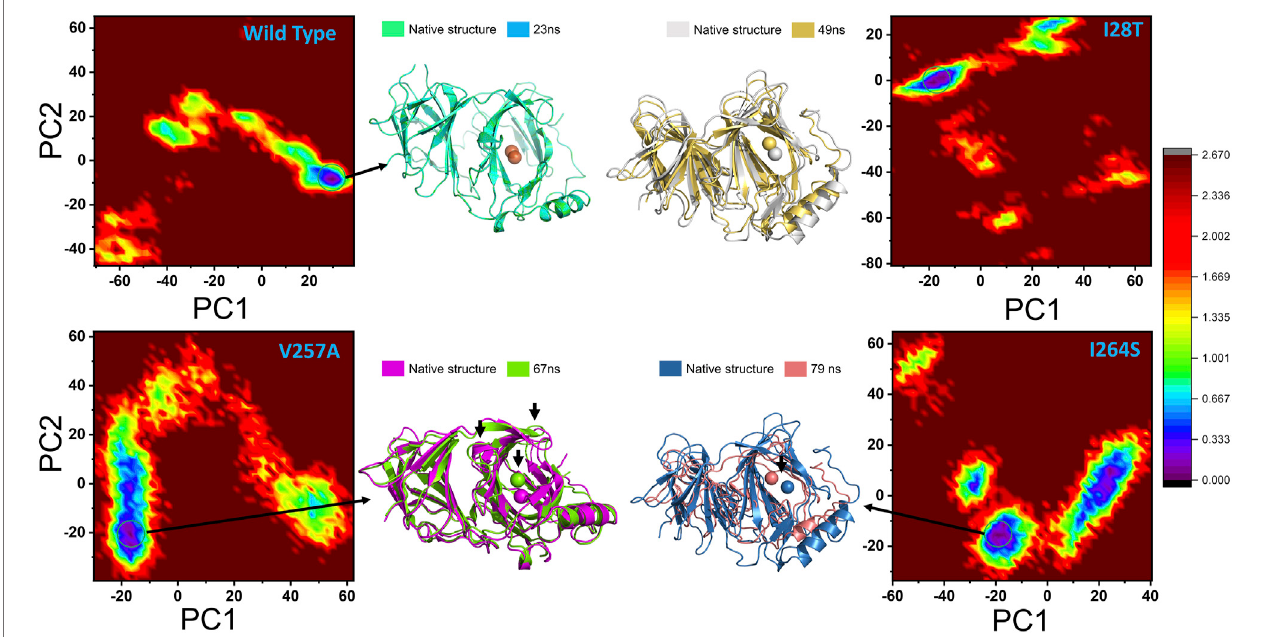
FIGURE 10 | Conformational changes during the molecular dynamics simulation are represented through the FEL. PC1 and PC2 are used to map the energy minima and extract the variations due to a speci fi c